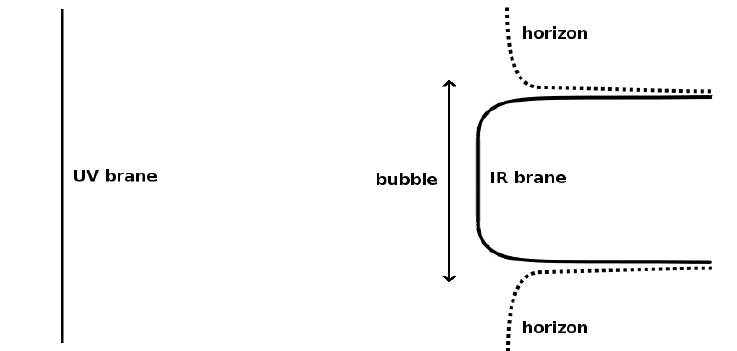
Figure 1 . Schematic depiction of the phase transition: a bubble of the Randall-Sundrum phase emerges from the surrounding AdS-Schwarzschild phase. In the transition region between the two phases, one sees the black hole horizon receding to in(cid:12)nity and subsequently the IR brane coming in from